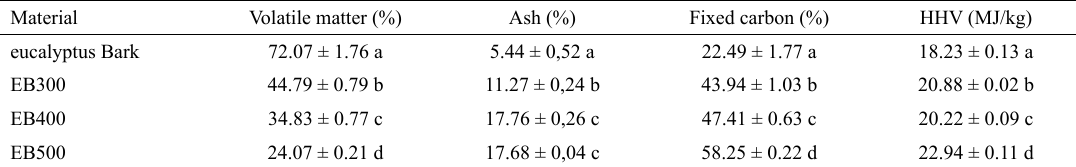
Table 1. Proximate analysis and HHV (dry